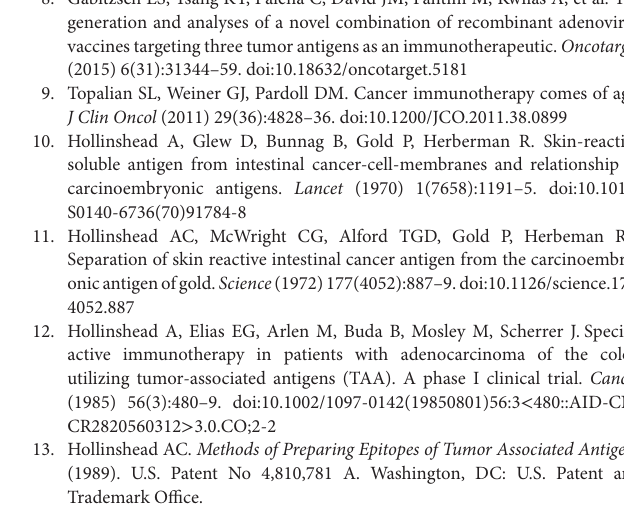
FigUre s1 | NEO-201 immunohistochemistry staining intensities of human tumor samples. Quantification of NEO-201 positive staining intensities from the human tumor microarray samples from various carcinoma tissues. Sample staining intensity was scored on a scale of negative, 1 + , 2 + , 3 + , and 4 + . n = number of